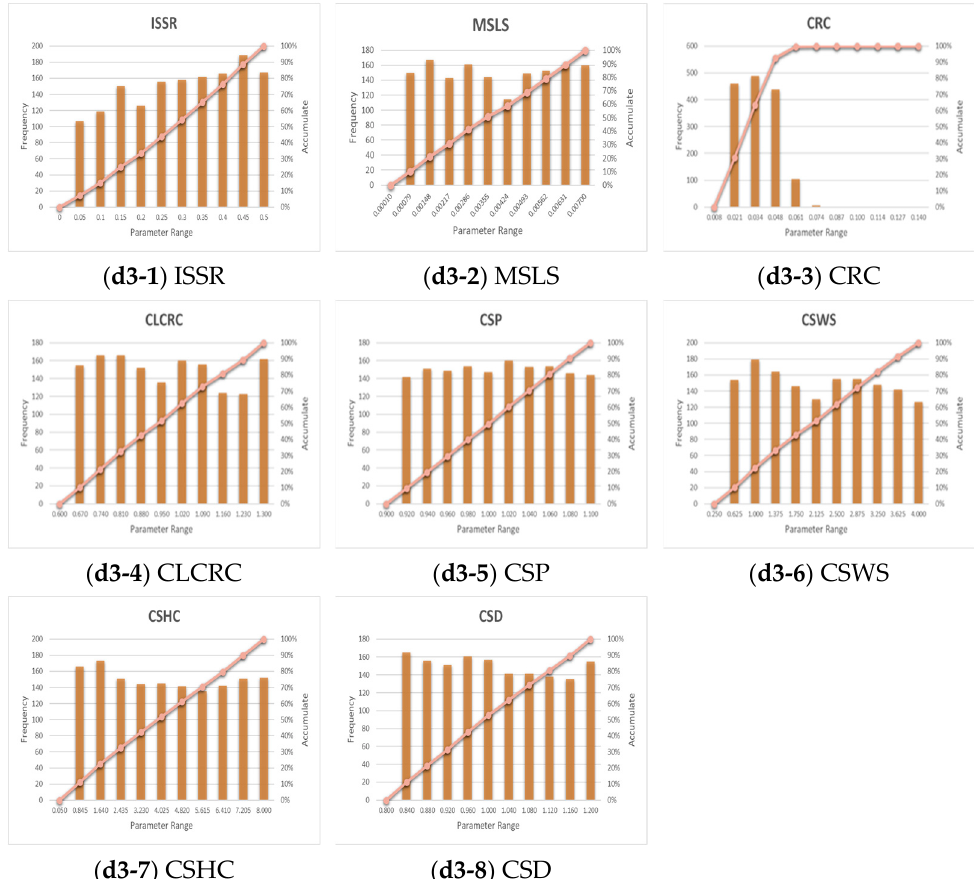
Figure 7. Event 1 parameter sensitivity (histogram/CDF). ( a3-1 − a3-8 ) LNSE results; ( b3-1 − b3-8 ) LPBIAS results; ( c3-1 − c3-8 ) LRSR results; ( d3-1 − d3-8 ) LLOG results.